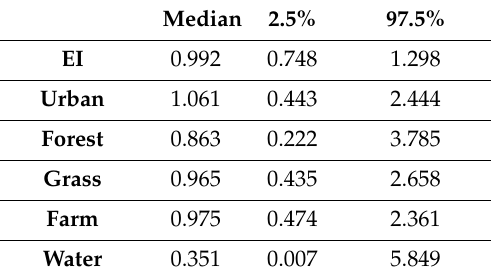
Table 2. A summary of the estimated covariate e ff ects on